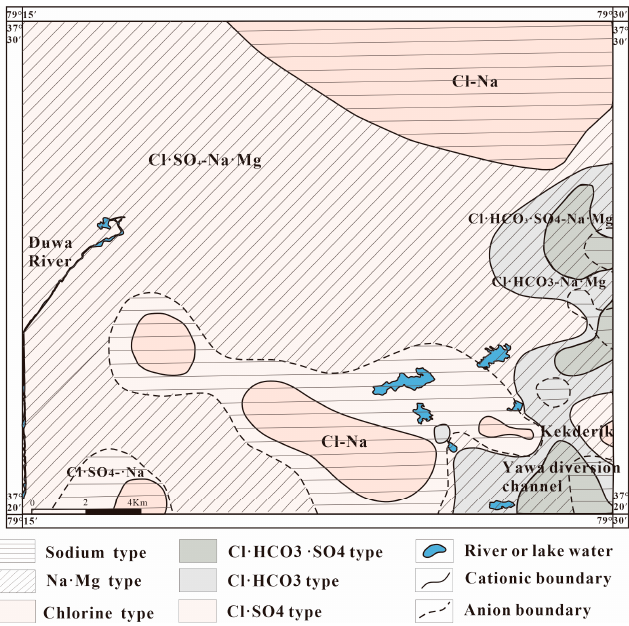
Figure 5. Hydrochemical types of groundwater in the study area.